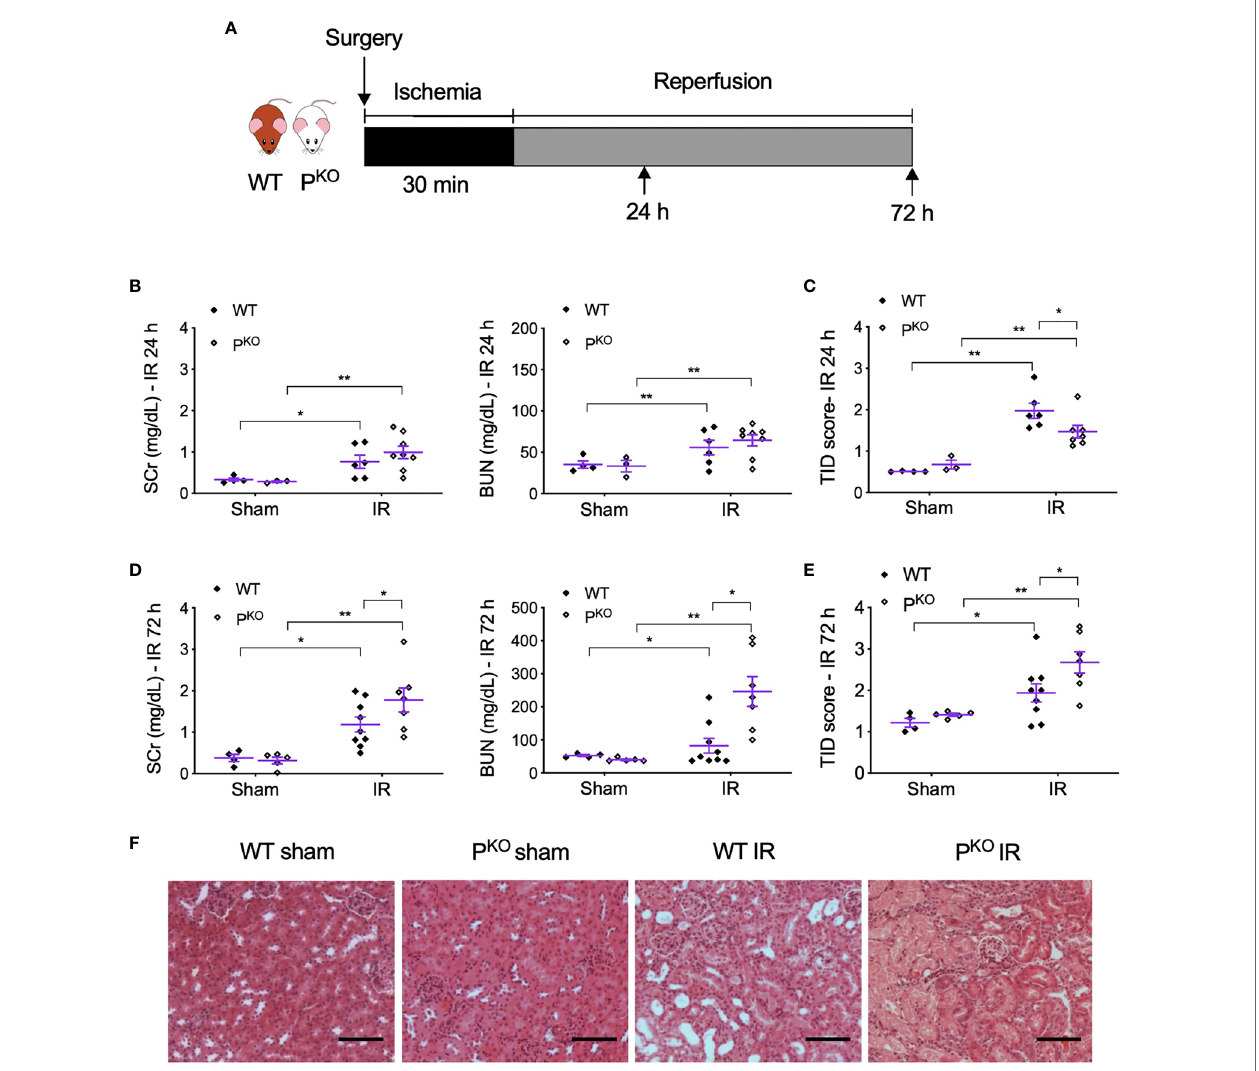
FIGURE 1 | P KO alleviated kidney structural damage at 24 h but aggravated renal functional and structural injury at 72 h post IR. (A) Schematic illustration of mouse experimental design. Bilateral kidney ischemia for 30 min and reperfusion for 24 h or 72 h were performed in male WT and P KO C57BL/6 mice. (B, C) SCr, BUN, and semiquantitative score of TID in both WT and P KO mice at 24 h were increased by IR, but only TID was improved by P KO (sham: n = 3 – 4; IR: n = 6 – 8). (D, E) At 72 h, SCr, BUN, and TID score in both WT and P KO mice were also elevated by IR, but all parameters were further increased by P KO (sham: n = 4 – 5; IR: n = 7 – 9). Data were shown as means ± SEMs, and analyzed by one-way ANOVA and LSD test. * p < 0.05; ** p < 0.01. (F) Representative H&E stained images showing the cortex structure of the kidney at 72 h post IR. Scale bar: 100 m